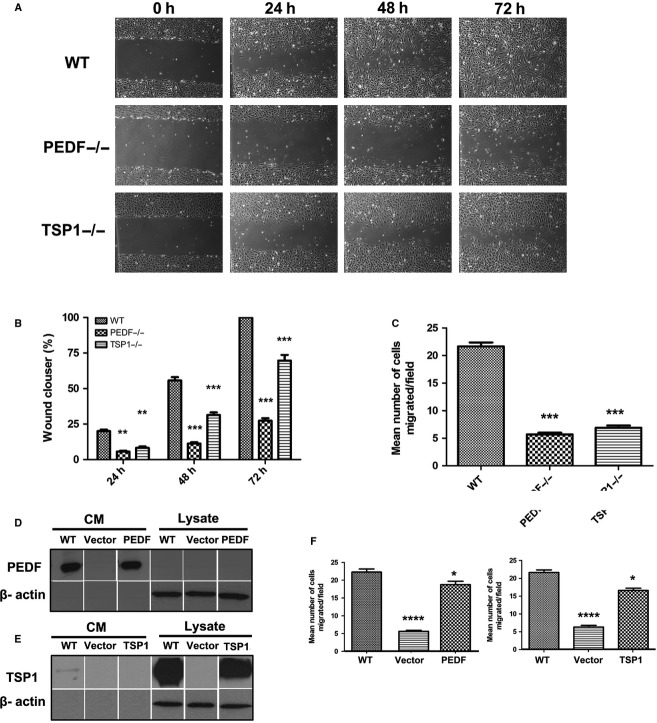
Attenuation of migration in PEDF−/− and TSP1−/− RPE cells. (A) Scratch wound assay of RPE cell monolayers on gelatin‐coated plates was used to determine cell migration. Wound closure was observed by phase microscopy at indicated time points. (B) The quantitative assessment of wound migration (**P < 0.01, ***P < 0.001, n = 3). (C) Migration of RPE cells in transwell assays. Please note a significant decrease in the migration of PEDF−/− and TSP1−/− RPE cells compared with WT cells (***P < 0.001, n = 3). (D and E) The re‐expression of PEDF and TSP1 in PEDF−/− and TSP1−/− RPE cells. PEDF−/− and TSP1−/− cells were infected with viruses encoding PEDF or TSP1 cDNAs as detailed in Material and Methods. The expression of PEDF and TSP1 was confirmed by Western blot analysis. These lanes are all from the same membrane and extraneous lanes were removed for uniform labeling of the Figure. (F) Reexpression of PEDF and TSP1 in PEDF−/− and TSP1−/− RPE cells restored their migration to near WT RPE cell as determined by transwell migration assay (*P < 0.05, ****P < 0.0001, n = 3).